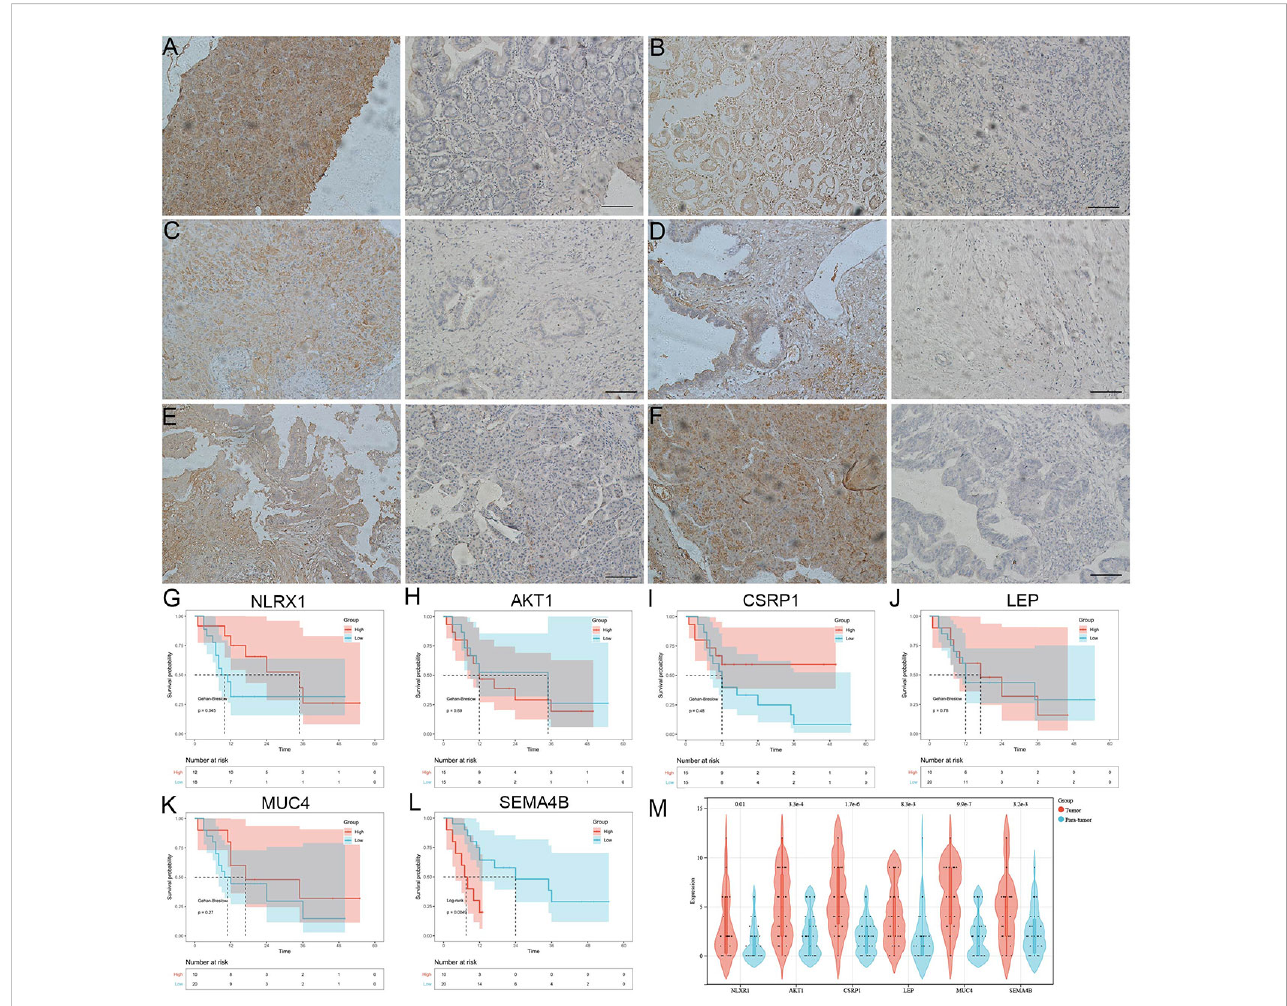
FIGURE 8 The analysis 6 genes using immunohistochemistry and KM survival curve. (A-F) the expression dysregulations of NLRX1, AKT1, CSRP1, LEP, MUC4 and SEMA4B in cancer tissues by immunohistochemistry. (G-L) Survival was better in patients with high NLRX1 expression and low SEMA4B expression compared with those with low NLRX1 expression and high SEMA4B expression. (M) 6 genes had difference expressions between cancer tissue and